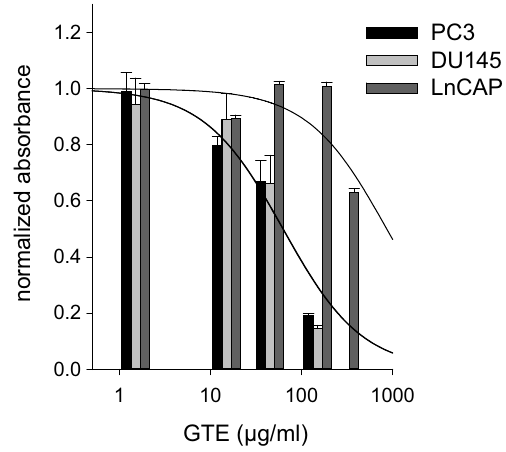
Figure 4: Dose – response data of cell viability obtained with the MTT assay after exposure of PCa cells to di ff erent concentrations of green tea extract ( 1.5, 15, 45, and 150 µg/mL GTE ) for 48 h. Bars represent mean ± SD of percent MTT - formazan absorbance ( see Materials and Methods section ) , normalized to the control absor - bance ( proliferation in the absence of GTE ) . In PC3 and DU145 cells, the IC 50 was 62 and 63 µg/mL, respectively. In LNCaP cells, the additional dose of 300 µg/mL GTE was tested and of IC 50 was esti - mated 862 µg/mL.